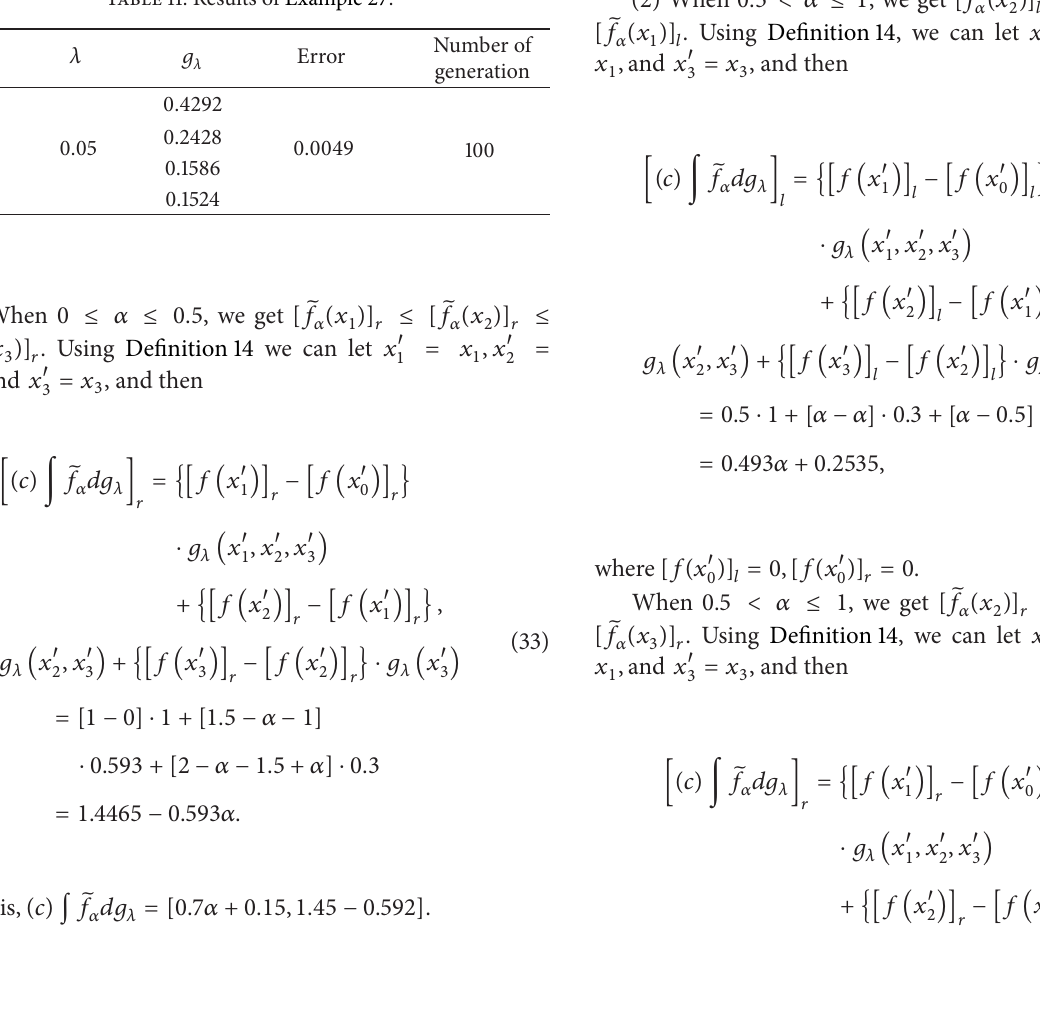
Table 11: Results of Example